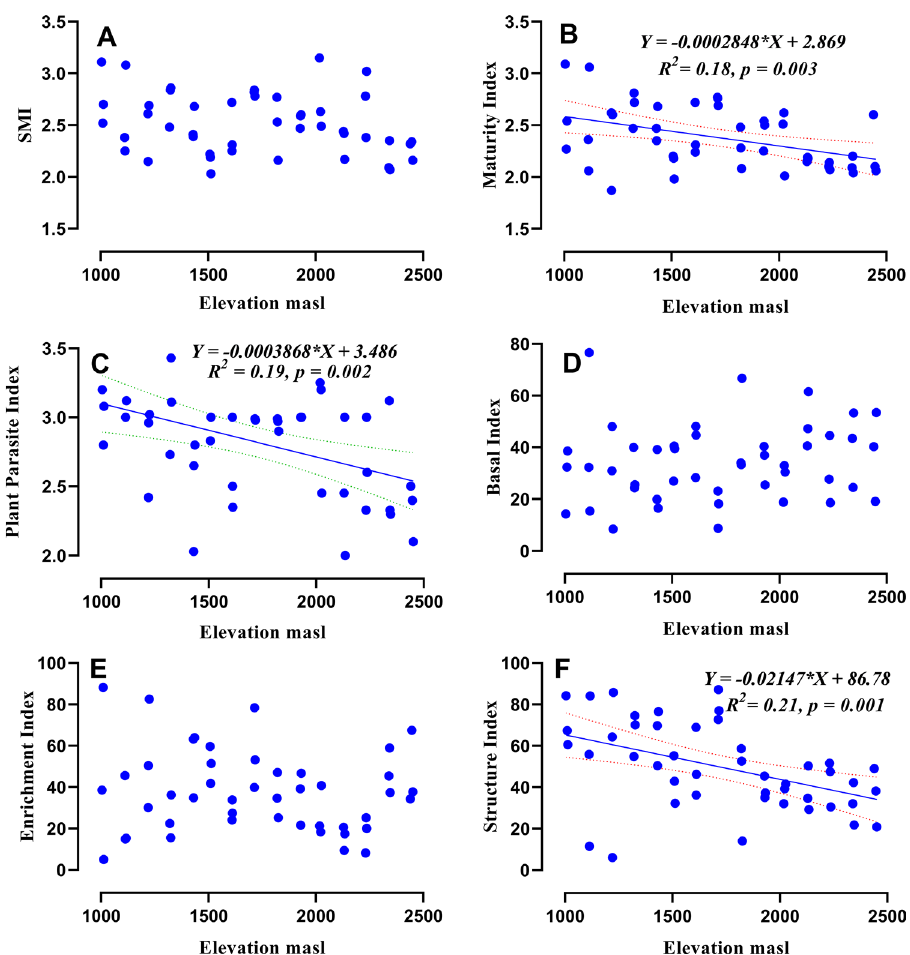
Figure 6. Relation between elevation and ΣMI ( A ), MI ( B ), PPI ( C ), BI ( D ), EI ( E ) and SI ( F ). Equation for Y , R 2 (coefficient of determination), p (significance) of linear regression, regression line and dotted lines of 95% of confidence interval are displayed only for significant